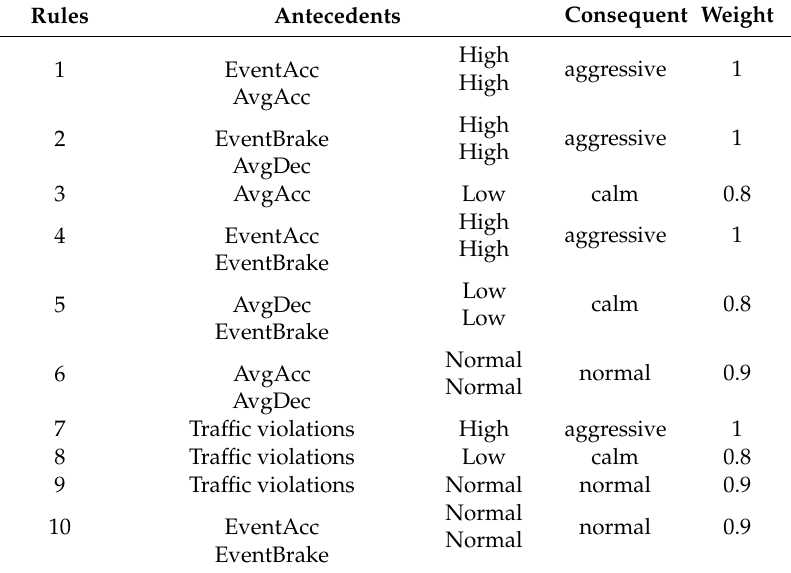
Table 2. Rules defined from inputs variables.